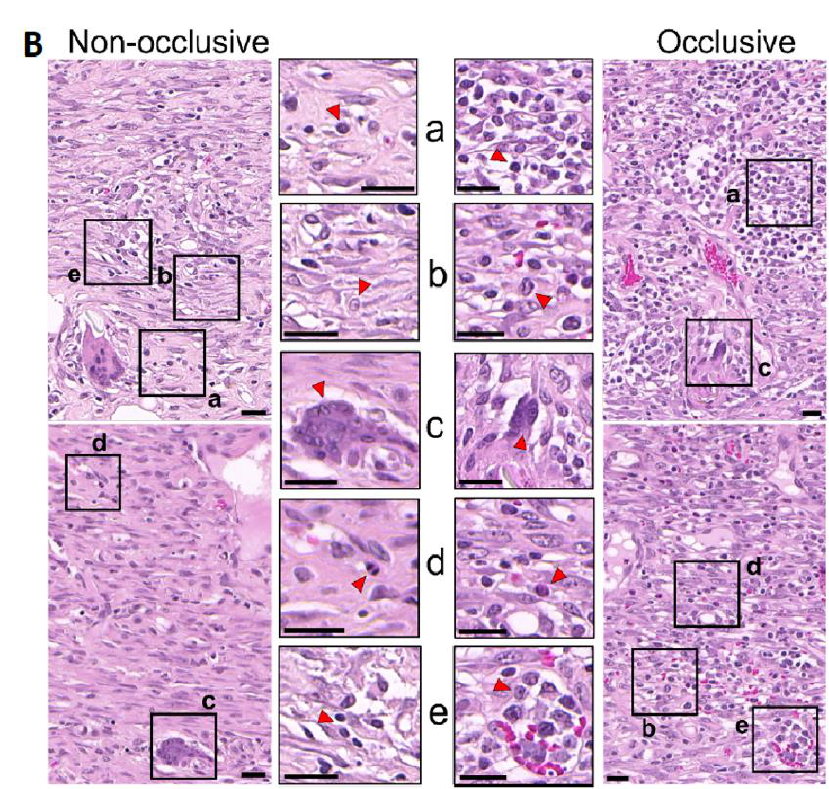
Figure 6. Histological aspects of new dermal tissue infiltrate composition. ( A ) Diagram with the pathology score, ranging from 0 to 5, for the presence of inflammatory cells in the newly formed dermal tissue: small- to mid-size mononuclear cell (SMC) (including lymphoblast) density; mono- cyte/histocyte/macrophage (Mo/His/Mac) density; epithelioid macrophage/multinucleate giant cell (EpMa/MGC) density; and granulocyte density, divided into eosinophils and neutrophils in both wounds treated with nonocclusive secondary wound dressing (cotton gauze—CG) and with occlu- ♦ sive dressing (OPSITE Flexifix—OP). ( B ) Example of hematoxylin and eosin (H&E) sections with four representative sites of the two secondary dressings (nonocclusive and occlusive). Highlighted in a higher magnification (red arrowheads) are examples on both tissues of SMCs ( a ), Mo/His/Mac ( b ), EpMa/MGCs ( c ), and granulocytes ( d ) as well as the presence of mononuclear cells forming clusters ( e ). The scale bar represents 20 µ